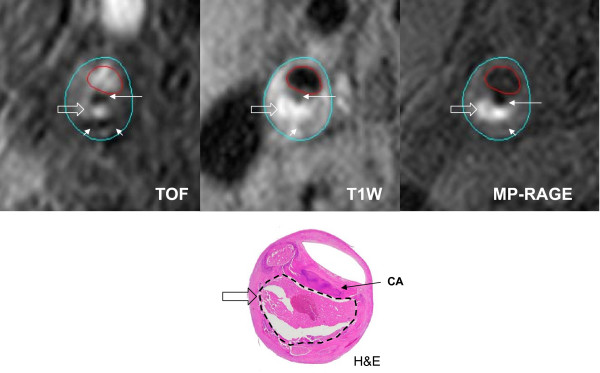
MR bright-blood sequence Time of Flight (TOF), and black-blood sequences T1W, and MPRAGE show a hyperintense signal (white block arrows) in the necrotic core. Hematoxylin and Eosin (H&E) stained matching histology shows a large necrotic core (broken lines) filled with hemorrhage. The hypointense signal (thin arrow) in the fibrous cap is shown by matching histology to be an area of calcification.